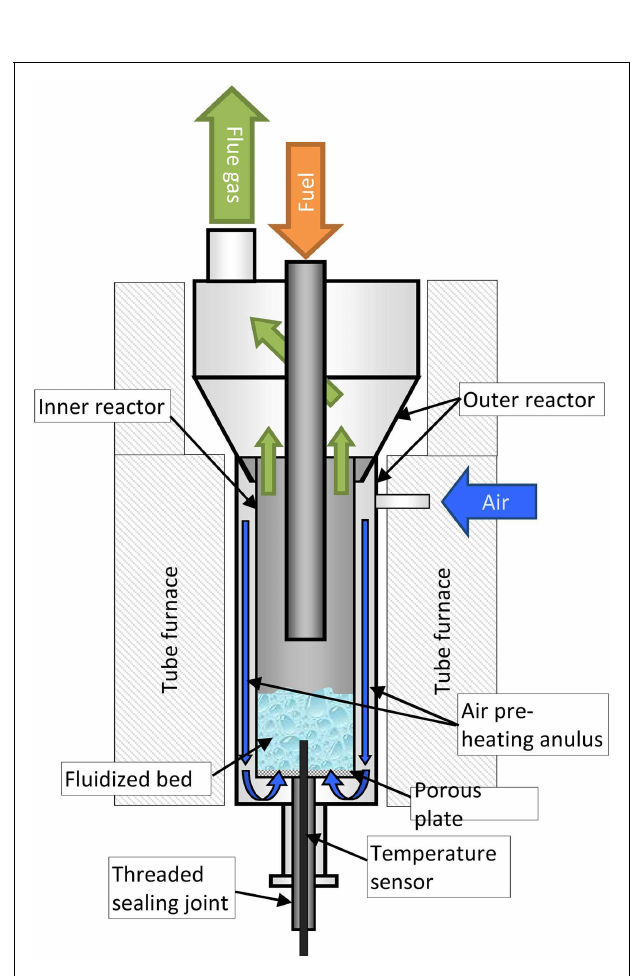
FIGURE 1 | Internal structure of the L.A.P.I.S. showing the electrical heating, outer and inner reactor walls . Primary air is pre-heated in the annulus between inner and outer